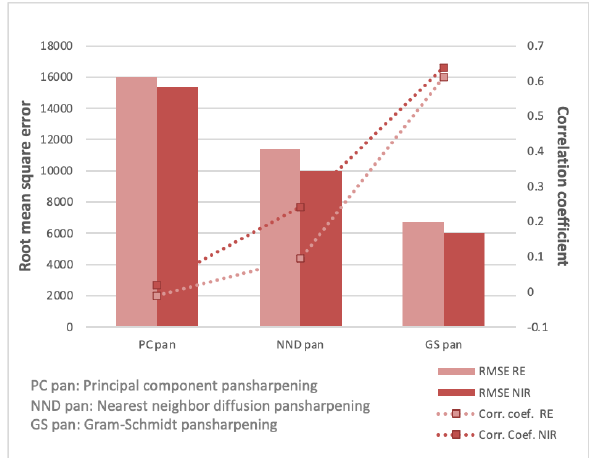
Figure 4. Barplot of the root mean square error and lineplot of the correlation coefficient of the three pansharpening algorithms for the red-edge (RE) and the near-infrared (NIR) channels. Respectively, the correlation coefficients are 0.61, -0.01, 0.09 for RE channel (Figure 4), and 0.63, 0.24, 0.02 for the NIR channel.